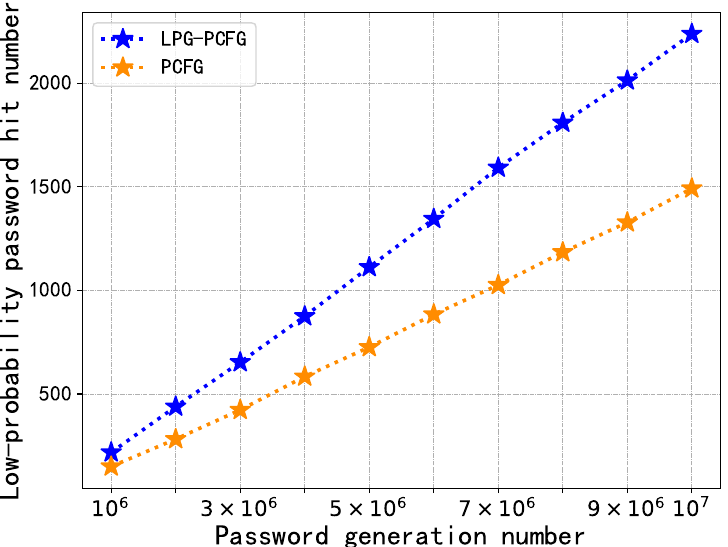
Figure 6. Performance comparison between LPG–PCFG and PCFG models (generated 10 7 times).